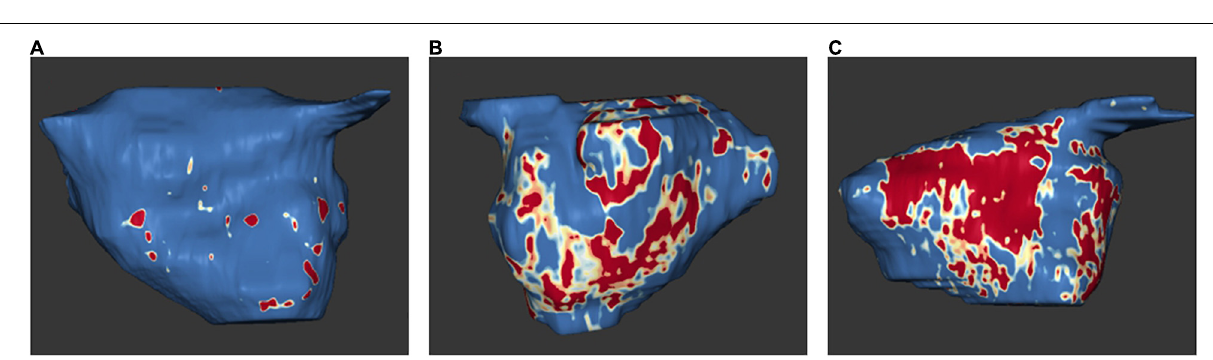
correlated significantly with the recurrence of arrhythmia